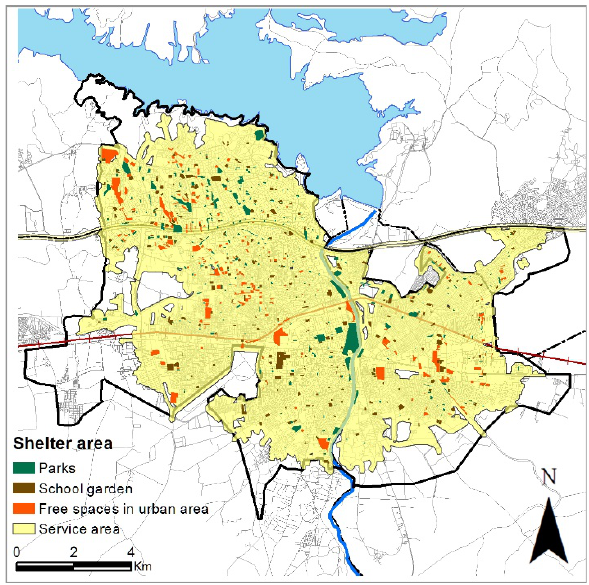
Figure 7: The service area of all shelters The second major problem was to satisfy basic needs after people access the shelter areas. The analysis incorporates many factors enhancing the suitability of site selection (e.g. shelter areas should be proximal to major roads) (Figure 8). A worst-case scenario where more than half of the inhabitants do not directly benefit from other services (health and food) is possible.